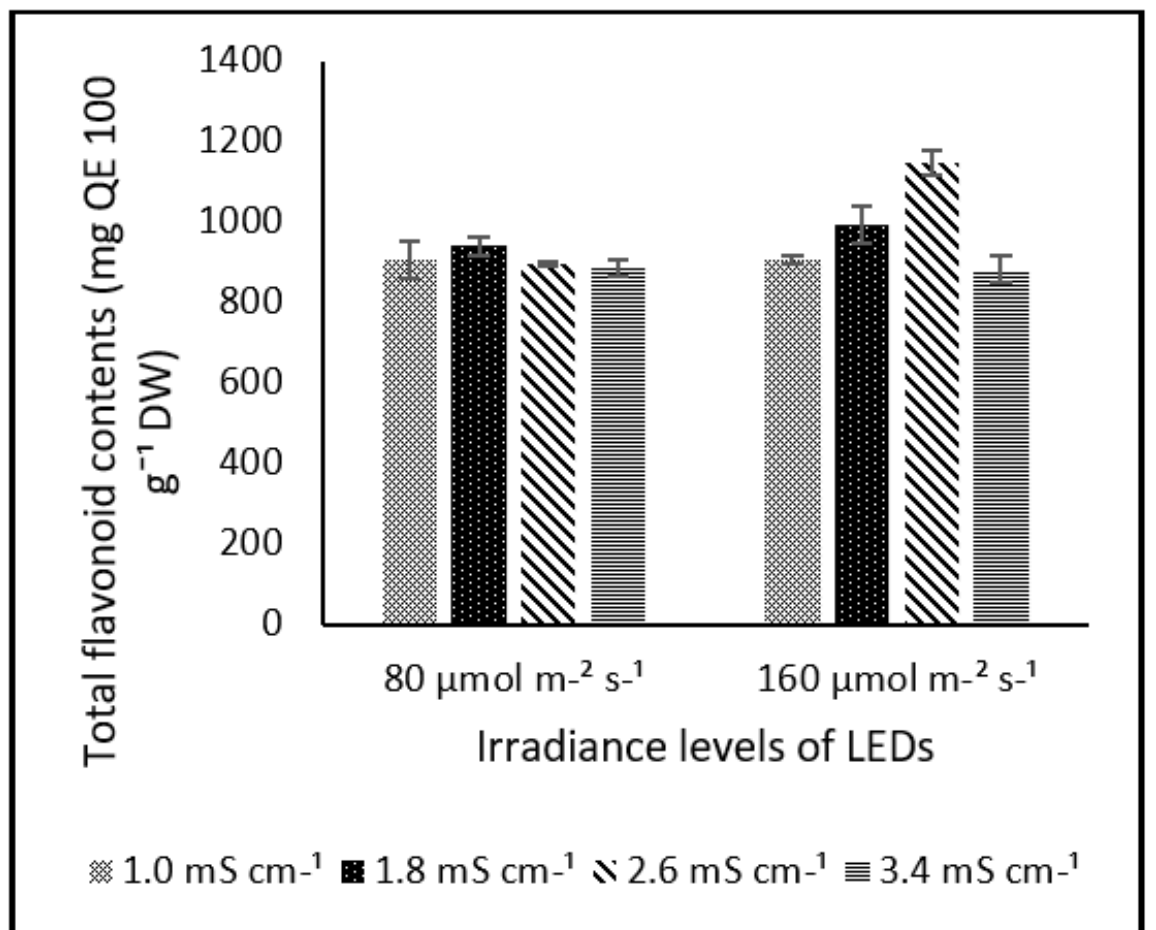
Figure 7. Interaction effect of LED irradiance levels and nutrient solution EC on total flavonoid content of lemon